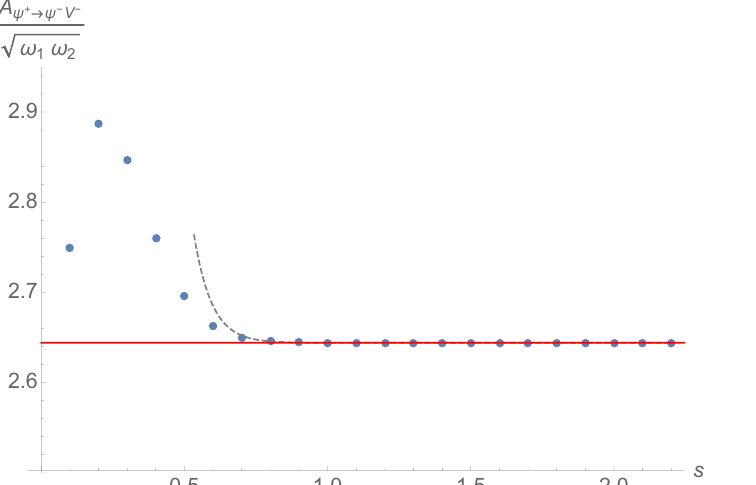
p = ! 1 ! 2 , dropping the prefactors in the (cid:12)rst (cid:9) s;s + ! ! (cid:9) s;s (cid:0) ! V (cid:0) ! 1 2 3